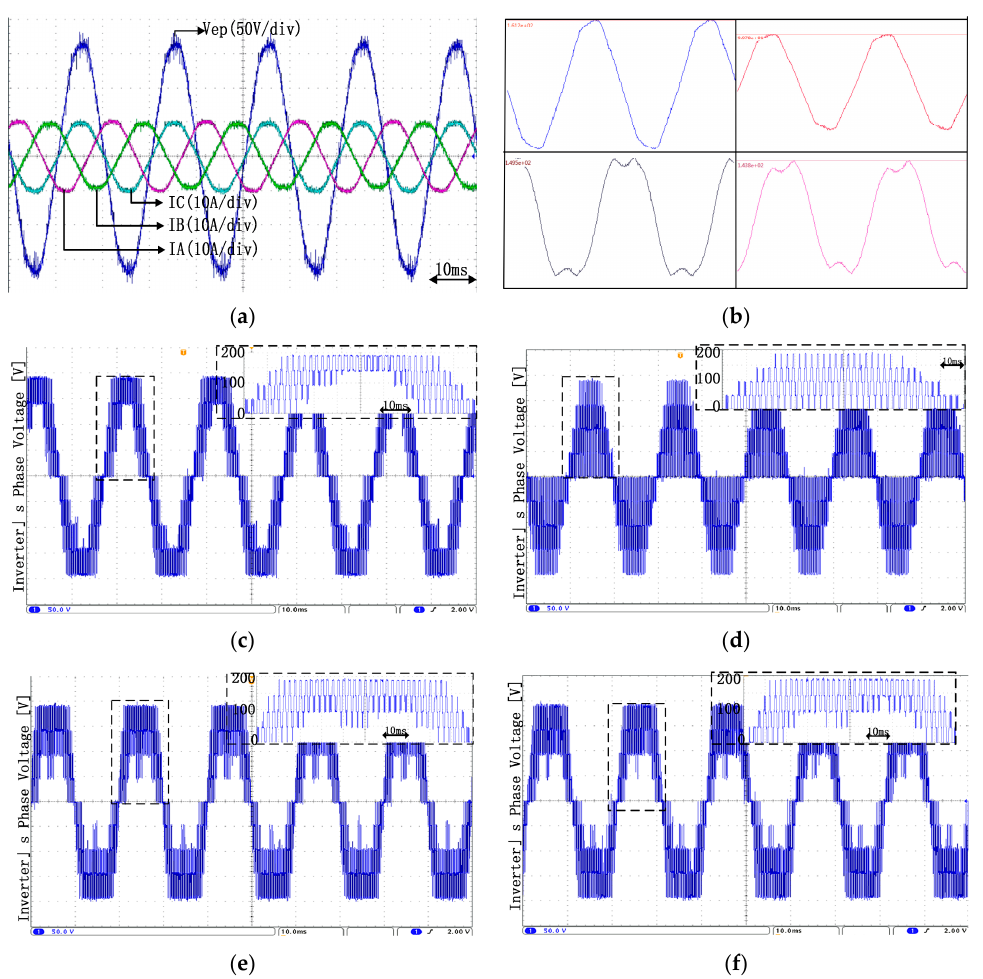
Figure 12. Experimental results in Case 2: the ( a ) grid voltages and currents; ( b ) modulating waveforms under different control strategies; ( c ) output phase voltages in conventional fault-tolerant control; ( d ) output phase voltage in FPSC; ( e ) output phase voltage in the THI; ( f ) output phase voltage in hybrid compensation control.